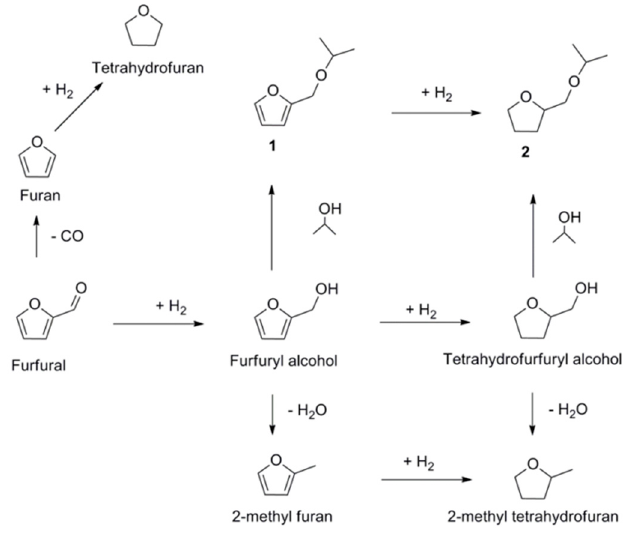
Figure 8. Schematic representation of reaction pathways during furfural hydrogenation using isopropanol as solvent.